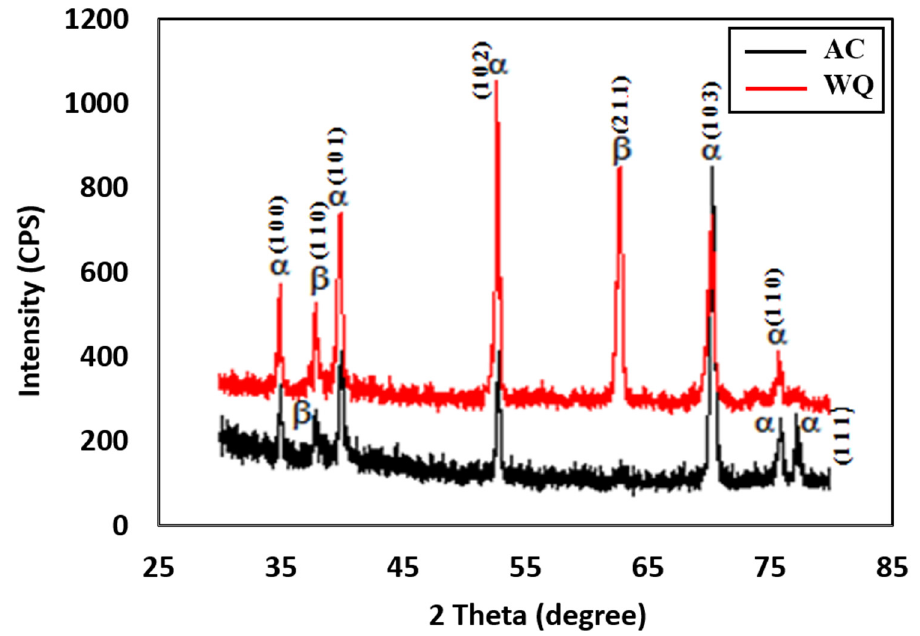
Figure 2. XRD spectra of WQ and AC samples. Table 2. XRD